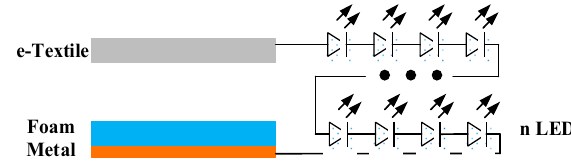
Figure 9. The Power Management Circuit for Powering a LED series.